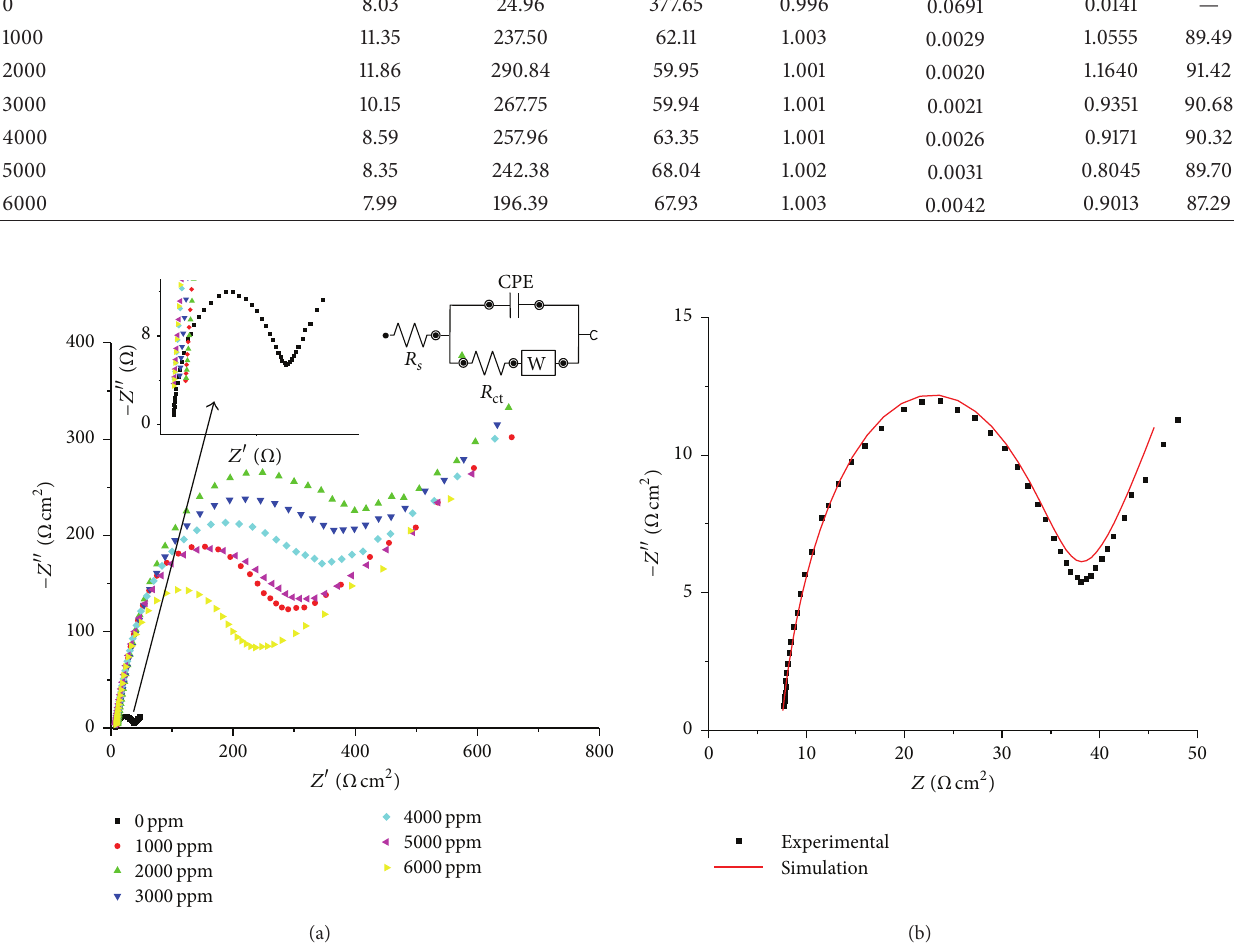
Figure 6: (a) Nyquist plots of 304SS in 0.5 MH 2 SO 4 with variations of inhibitor concentration and equivalent circuit model used to fit the Nyquist plots, and (b) a representative of fitting example of Nyquist diagrams for 304SS in 0.5 MH 2 SO 4